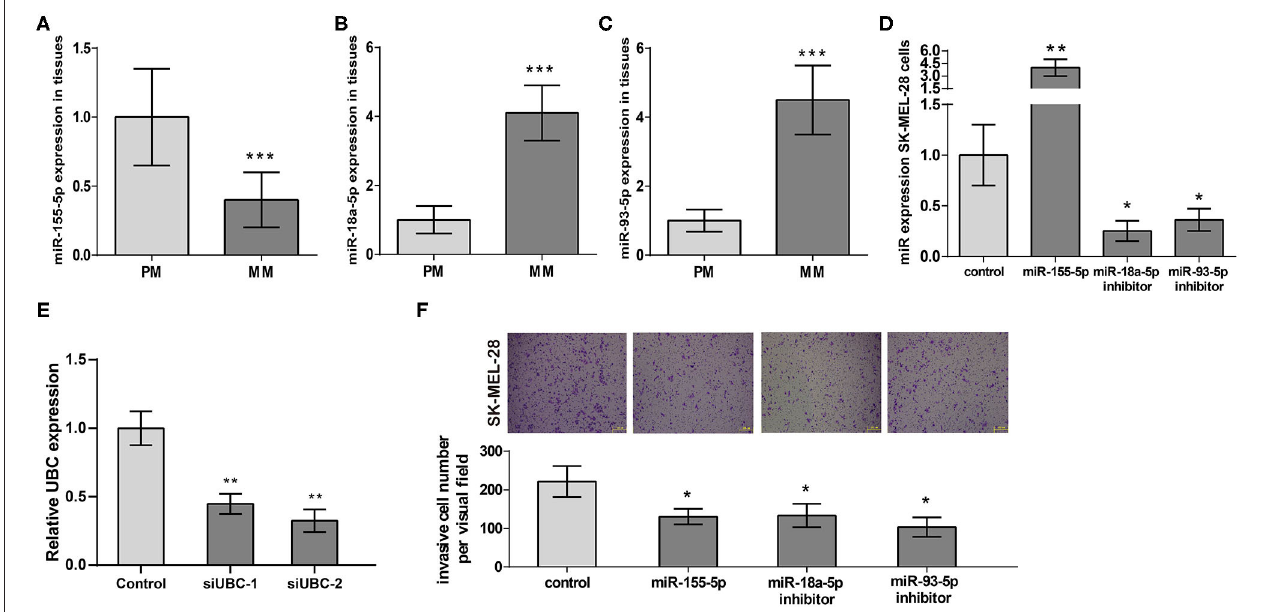
FIGURE 4 | The expression and prognostic functions of miR-155-5p, miR-18a-5p, and miR-93-5p in melanoma metastasis. (A–C) miR-155-5p’s, miR-18a-5p’s, and miR-93-5p’s expression in metastatic melanoma tissues ( n = 15) and primary tissues ( n = 18). (D) Validation of miR-155-5p expression, miR-18a-5p expression, and miR-93-5p expression in transfected SK-MEL-28 cells. (E) Validation of UBC expression in transfected SK-MEL-28 cells. (F) SK-MEL-28 transfected with miR-155-5p, miR-18a-5p inhibitor, or miR-93-5p inhibitor invaded less vs. control cancer cells. *** P < 0.001, ** P < 0.01, * P < 0.05. PM, primary melanoma; MM, metastatic